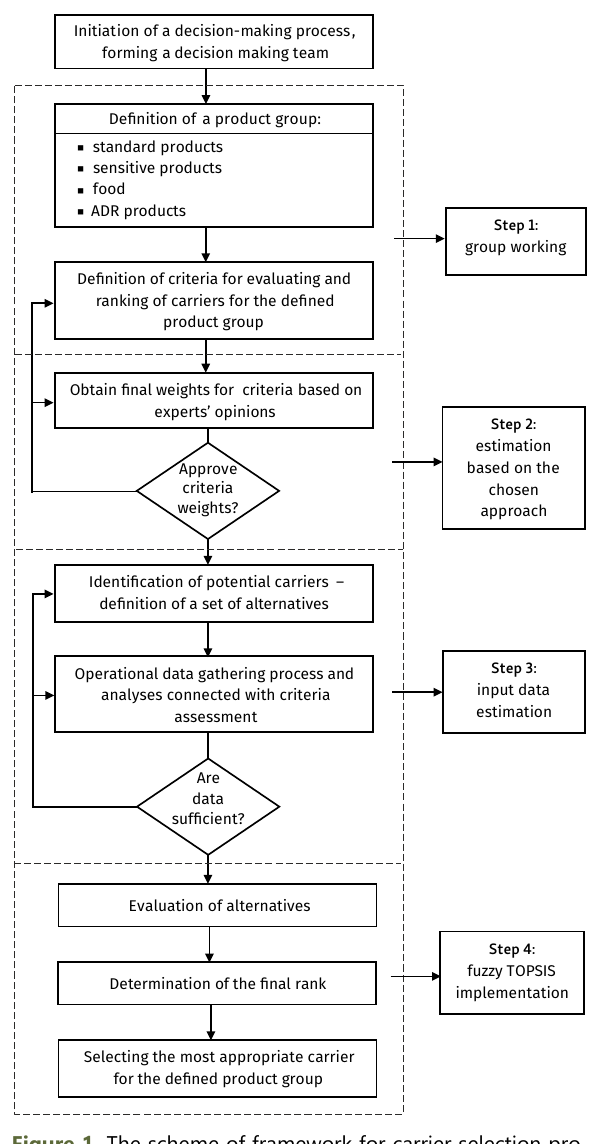
Figure 1. The scheme of framework for carrier selection pro- cess under uncertainty (source: own contribution)